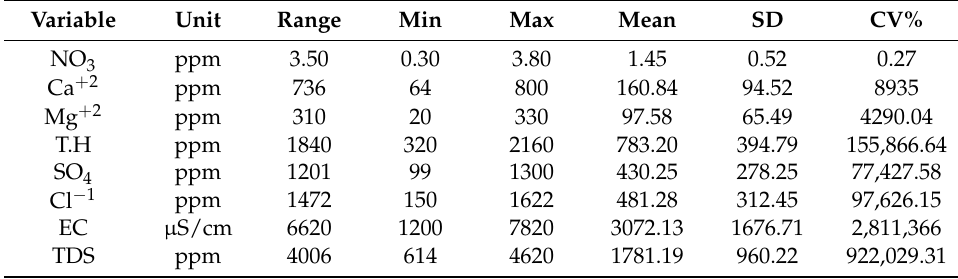
Table 2. Summary of statistical parameters of input and output variables (n = 84).